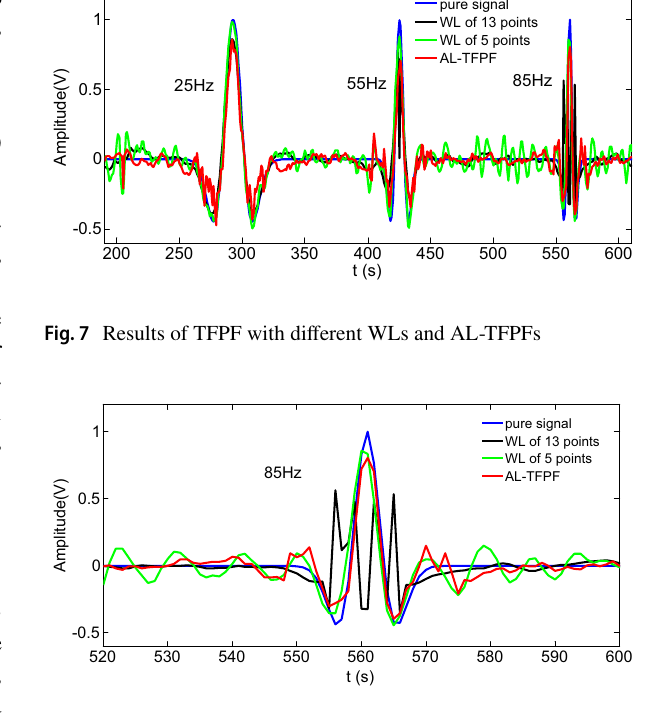
Fig. 8 Enlarged section of 85